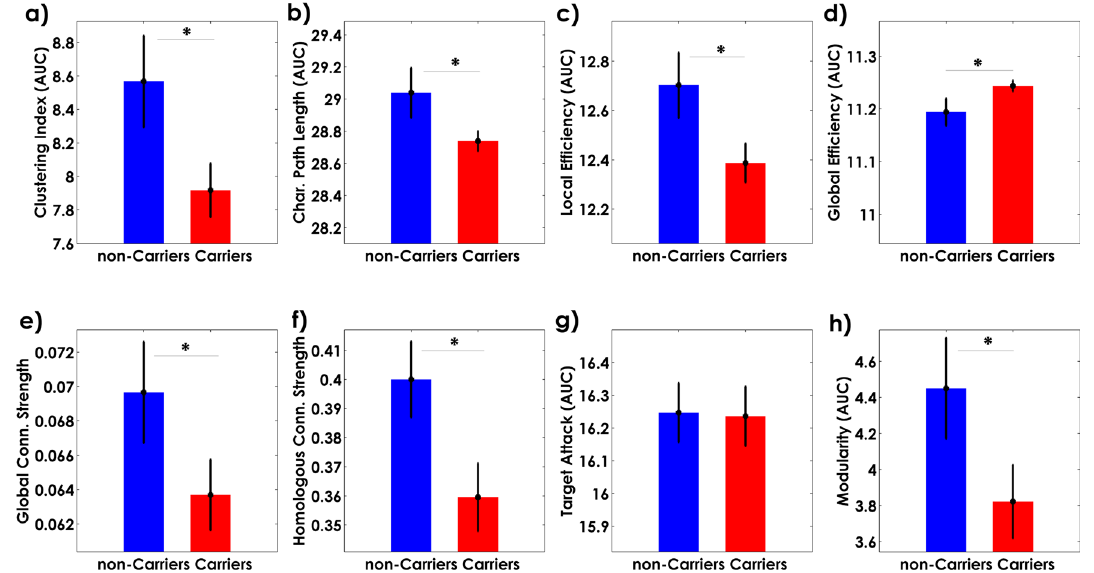
Figure 5. The area under the curves (AUC) of the cortical thickness covariance global properties. The bar heights represent the mean of the network properties, and the error bars are their standard deviation.